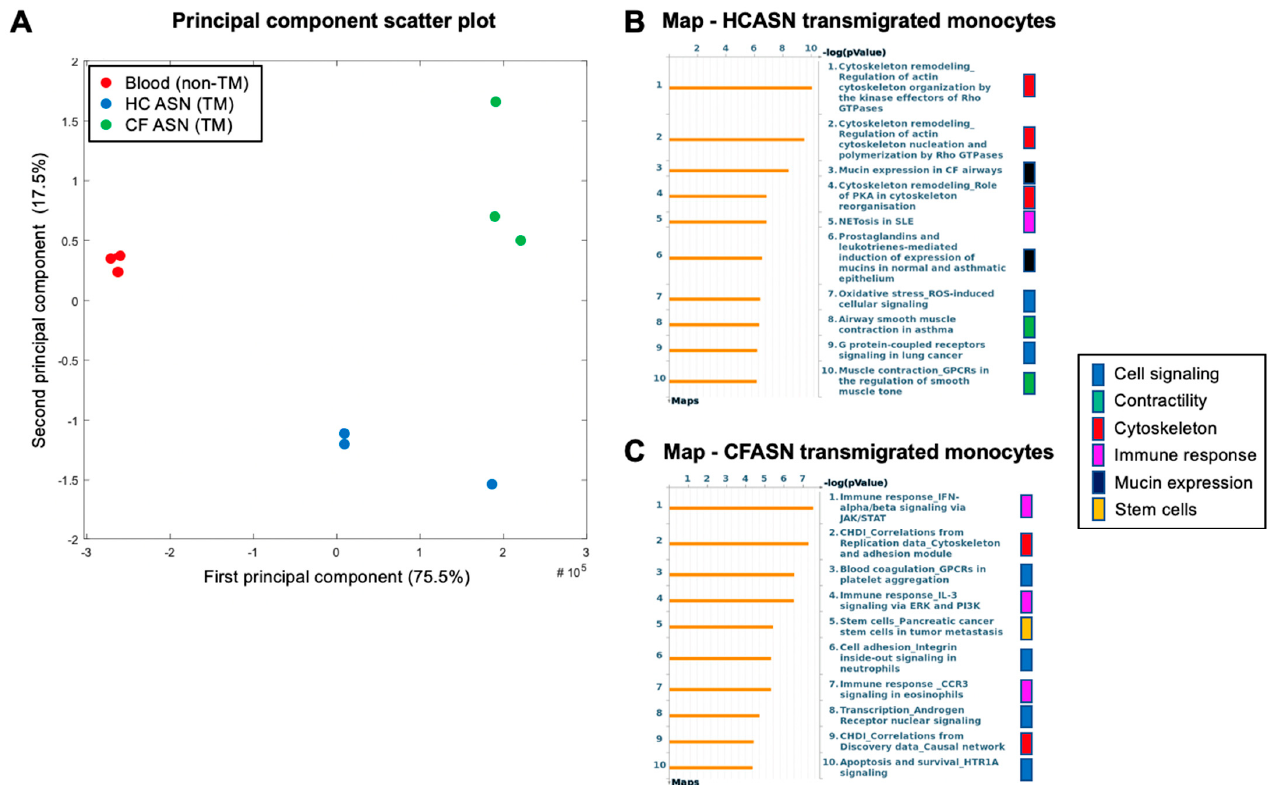
Figure 5. Transcriptomic analysis of transmigrated monocytes. ( A ) Principal component analysis of RNASeq data from healthy control blood monocytes prior to (non-transmigrated, red) and after transmigration (TM) to HC (blue) or CFASN (green) shows clear subsetting by condition ( n = 3 independent biological replicates each). Pathway analysis by Metacore (right) illustrating differentially expressed genes and pathways in monocytes transmigrated to ( B ) HCASN and ( C ) CFASN, respectively, compared to blood monocytes.